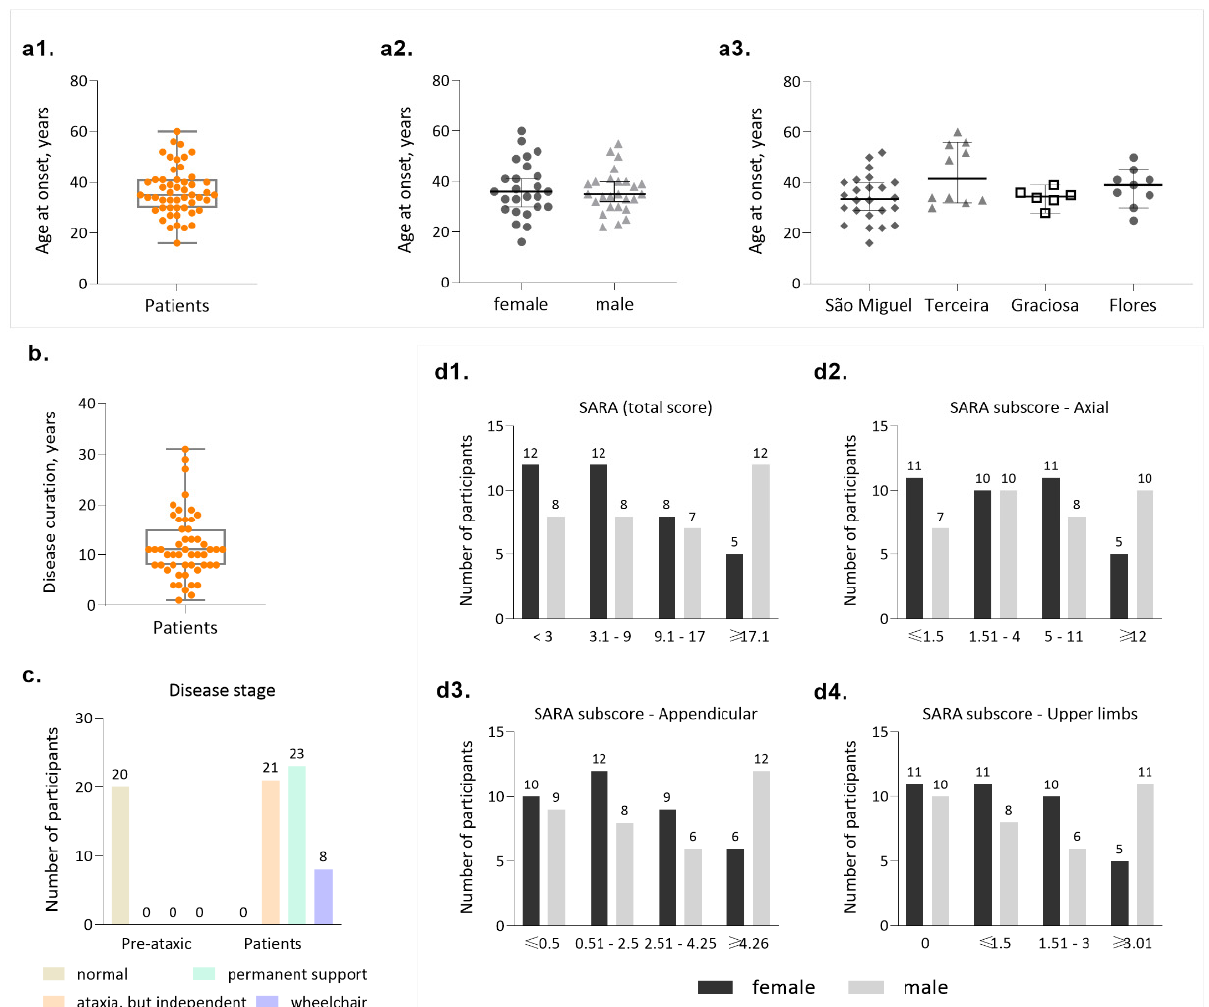
Figure 3. Main clinical features of the MJD Azorean cohort. ( a1 ) Distribution of age at onset in MJD patients; ( a2 ) Distribution of age at onset by gender; ( a3 ) Distribution of age at onset by island of birth of the patients; ( b ) Disease duration in patients; ( c ) Frequencies of disease stages, as proposed by Klockgether and collaborators (1998); ( d1 ) Distribution of patients by categories of the total SARA score (maximum score = 40); ( d2 ) Distribution of patients by categories of the axial subscore of SARA (maximum subscore = 18); ( d3 ) Distribution of patients by categories of the appendicular subscore of SARA (maximum subscore = 12); ( d4 ) Distribution of patients by categories of the upper limbs subscore of SARA (maximum subscore = 12).